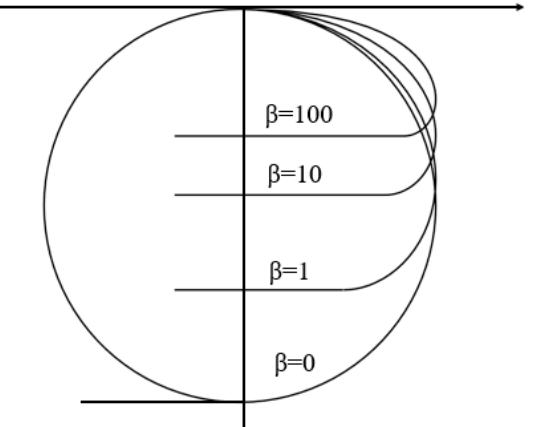
Figure 2. A family of axisymmetric heavy droplet profiles with different b ( β )